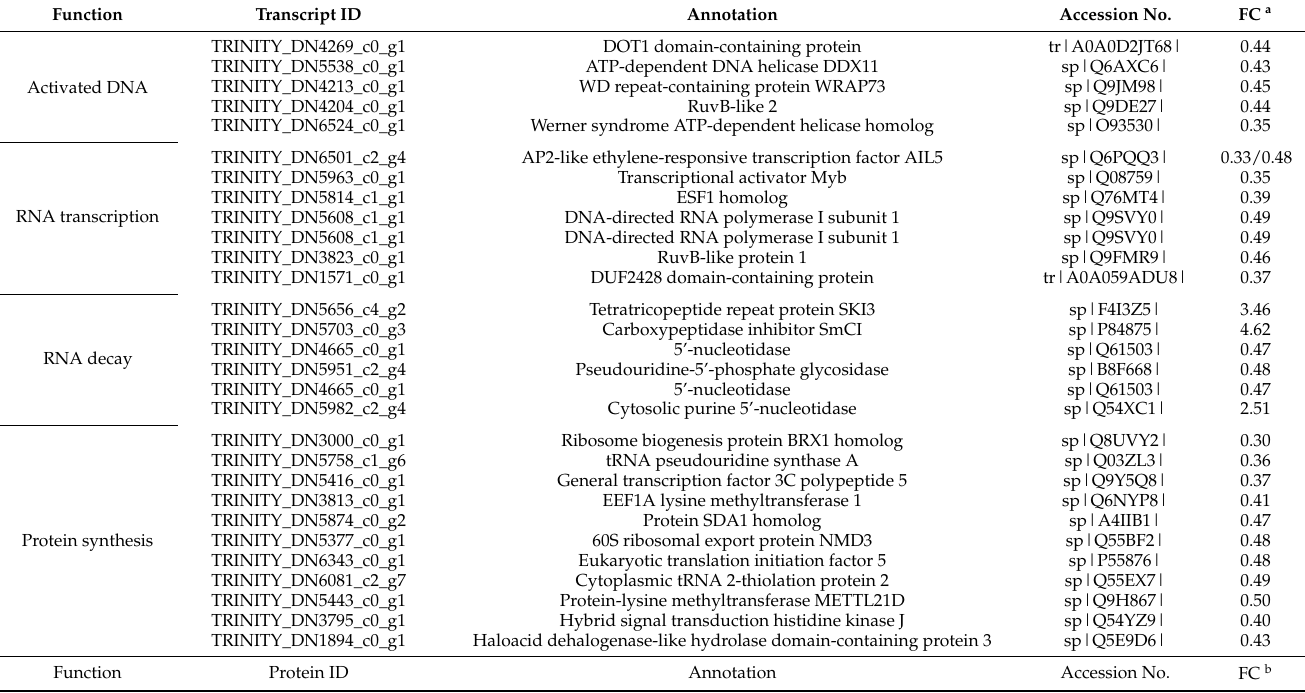
Table 3. Fluctuation of molecules in U. prolifera on transcription and translation after 12 h treatment with high